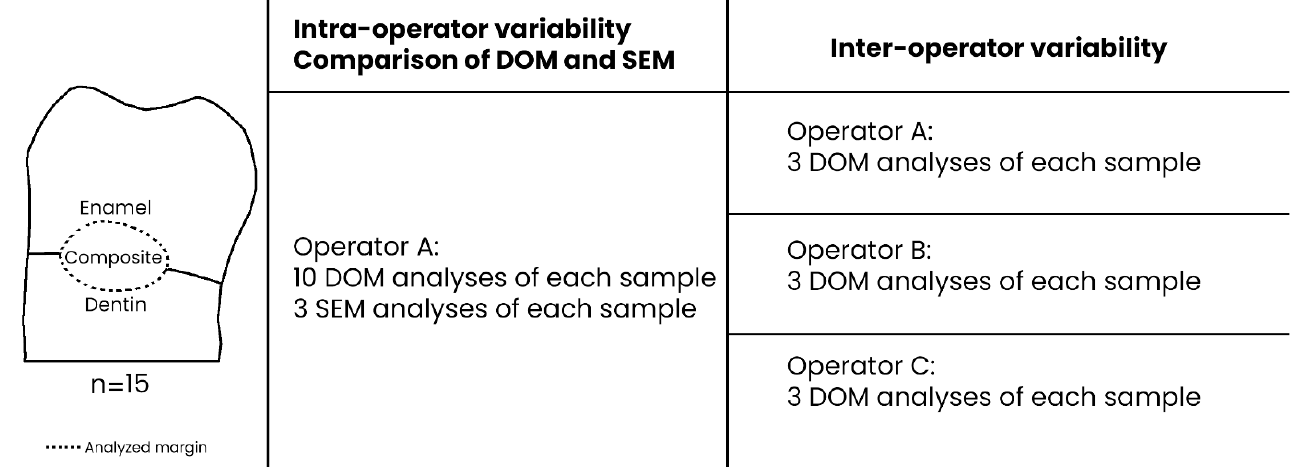
Figure 2. Representation of the study